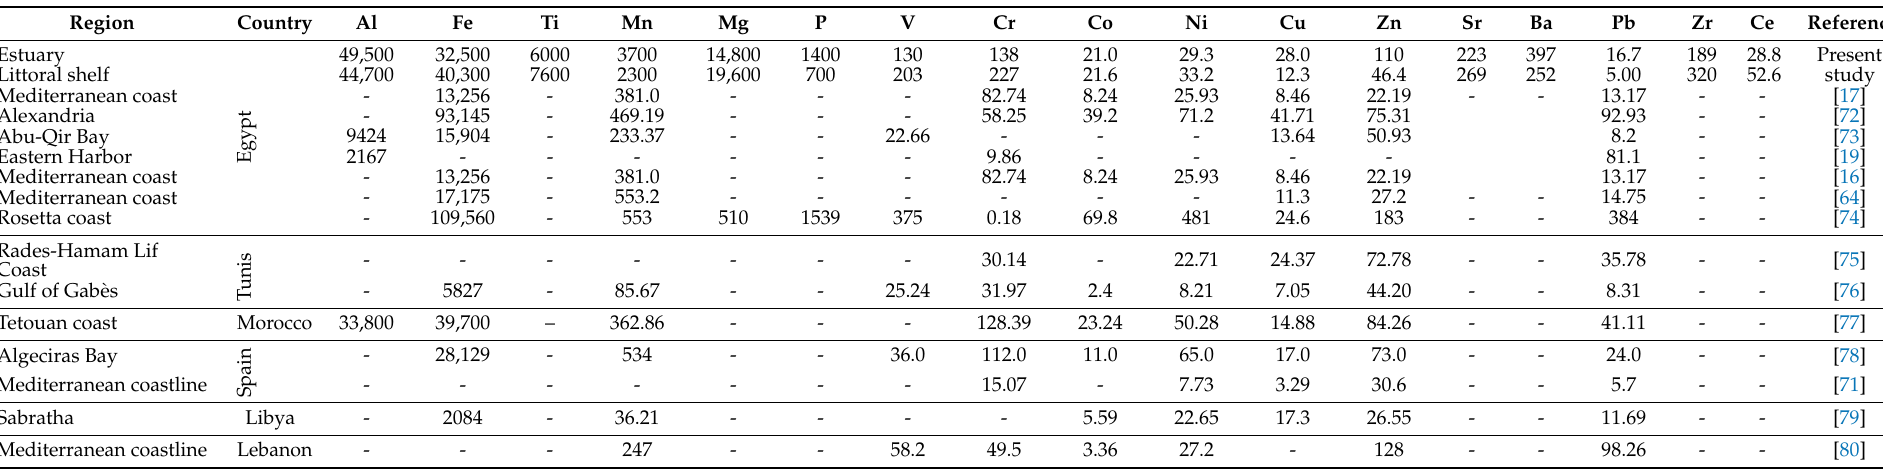
Table 3. Comparison of potentially toxic element averages (ppm) in surface sediment of the current investigation with other studies in the Mediterranean Sea region.